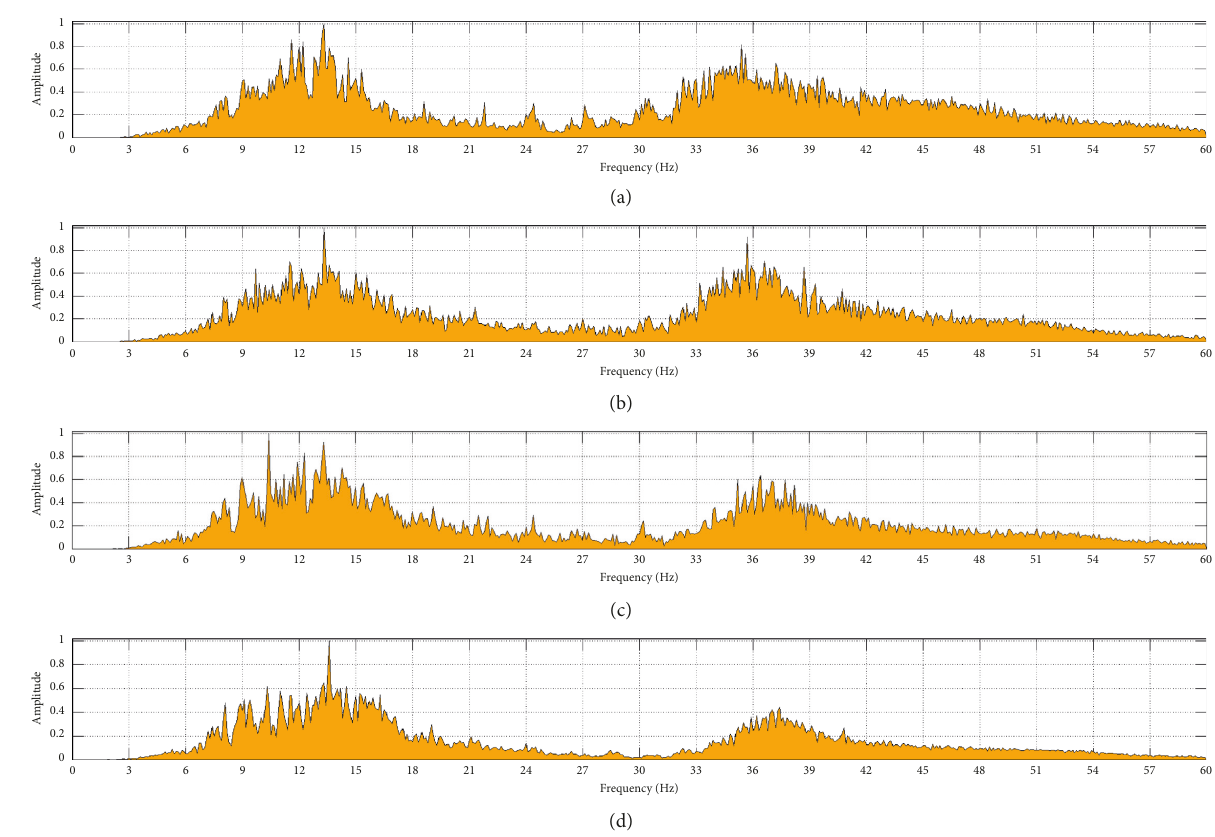
Figure 16: Power spectral density of beams corresponding to different fatigue states.